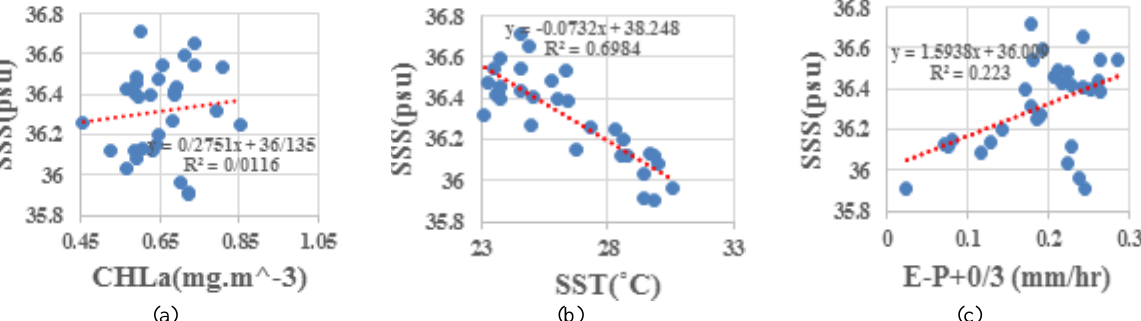
Figure 5. Scatter plot between SSS and (a) CHLa, (b) SST, and (c) E-P based on the monthly mean for 2012-2014.